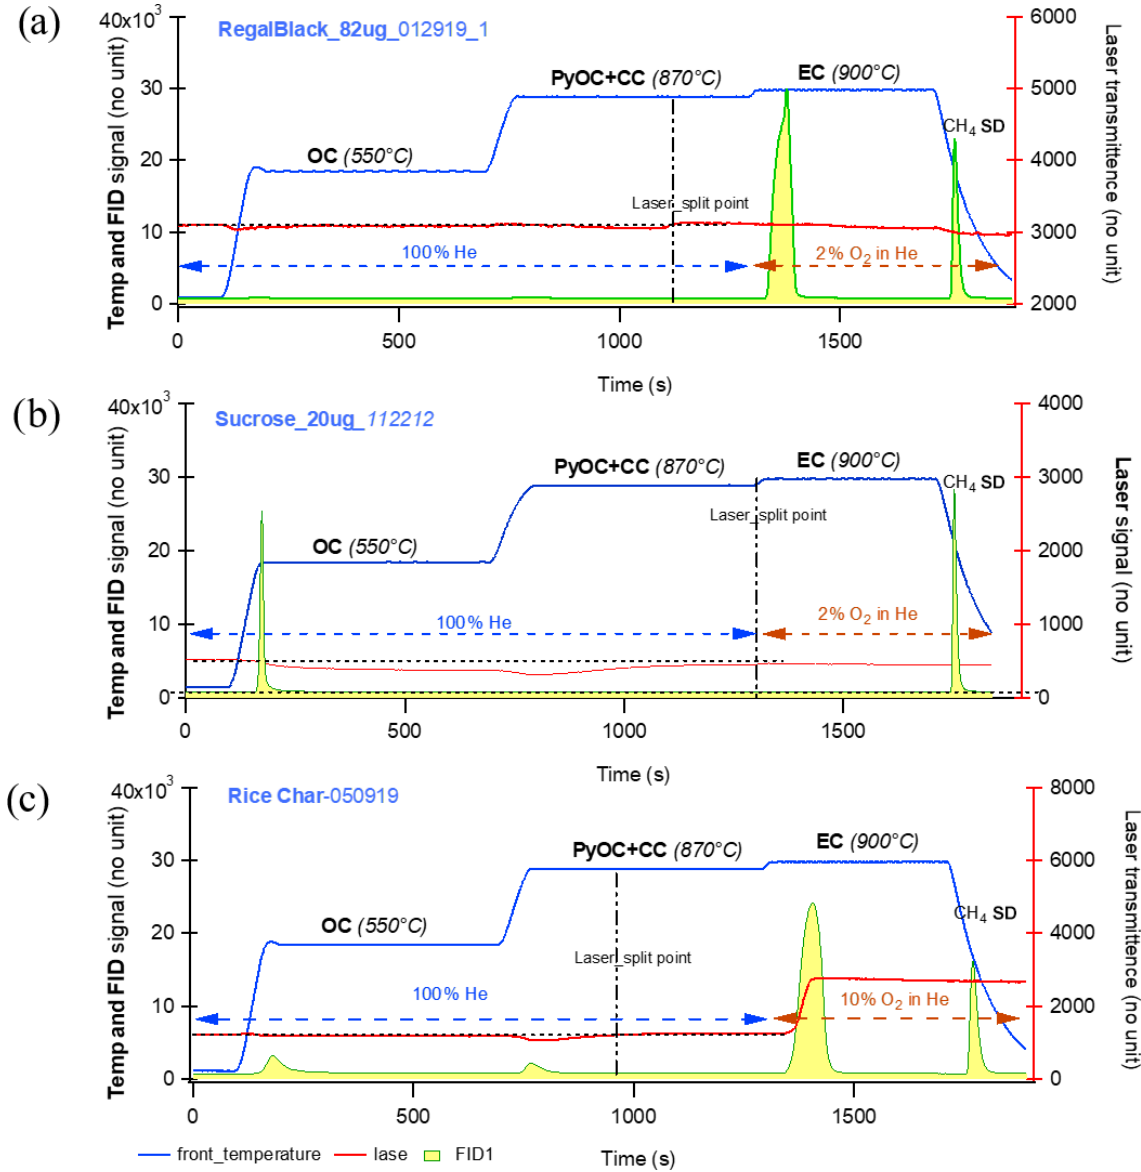
Figure 6. Thermograms of pure or bulk references: (a) regal black, (b) sucrose, and (c) rice char. Temperature (solid blue line) and FID signals (integrated yellow area with green line) on the left axes and laser (solid red line) on the right axis. It is observed that on the three thermograms during the temperature stage of 870 ◦ C, the laser transmittance signals decrease first and increase again before the next temperature stage, minimizing PyOC fraction, i.e., possible charred OC contribution to